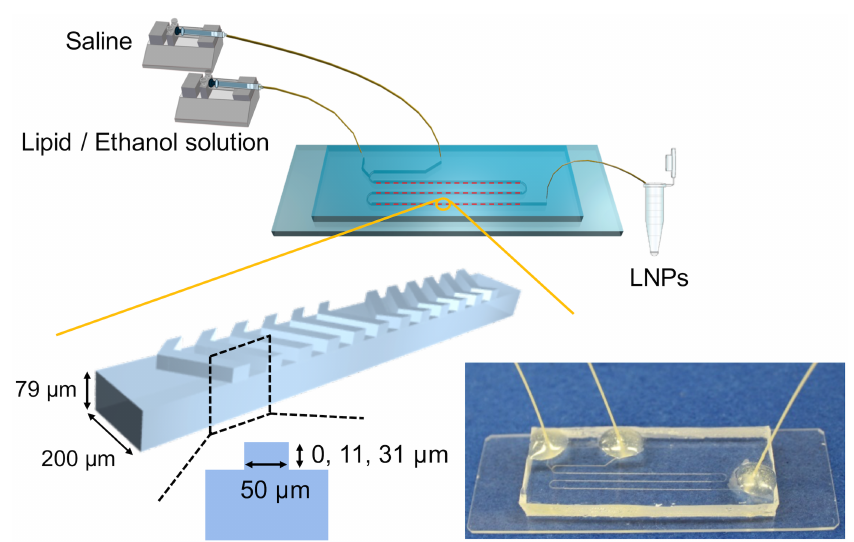
Fig 1. Schematic illustration and photograph of the experimental setup. The width and depth of the microchannel were 200 and 79 μ m. The total lengthof microchannel was 110 mm. The heightsof the chaotic mixer structures were 0, 11, and 31 μ m, for the NC device (without micromixers), the CM_11 device, and the CM_31 device, respectively. An enlargedimage shows one cycle of the chaotic mixer structures. The CM_11 and CM_31 deviceswere equippedwith 69 cycles of chaotic mixer